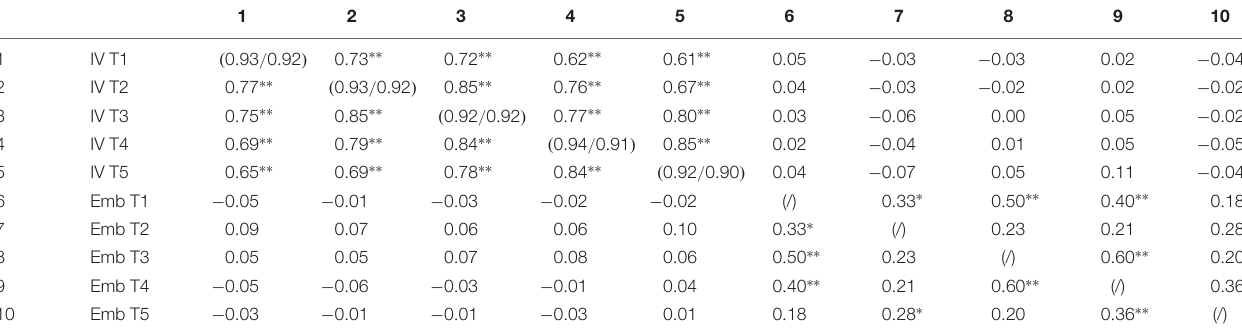
TABLE 1 | Summary statistics for intrinsic value Mathematics and English (latent level).